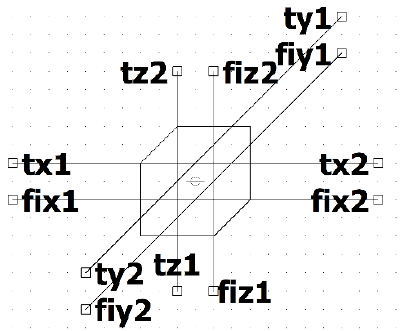
Figure 7. The symbol of the hierarchical block of the 3D equivalent circuit of elemental volume shown in Figure 6 for LTSpice [30].